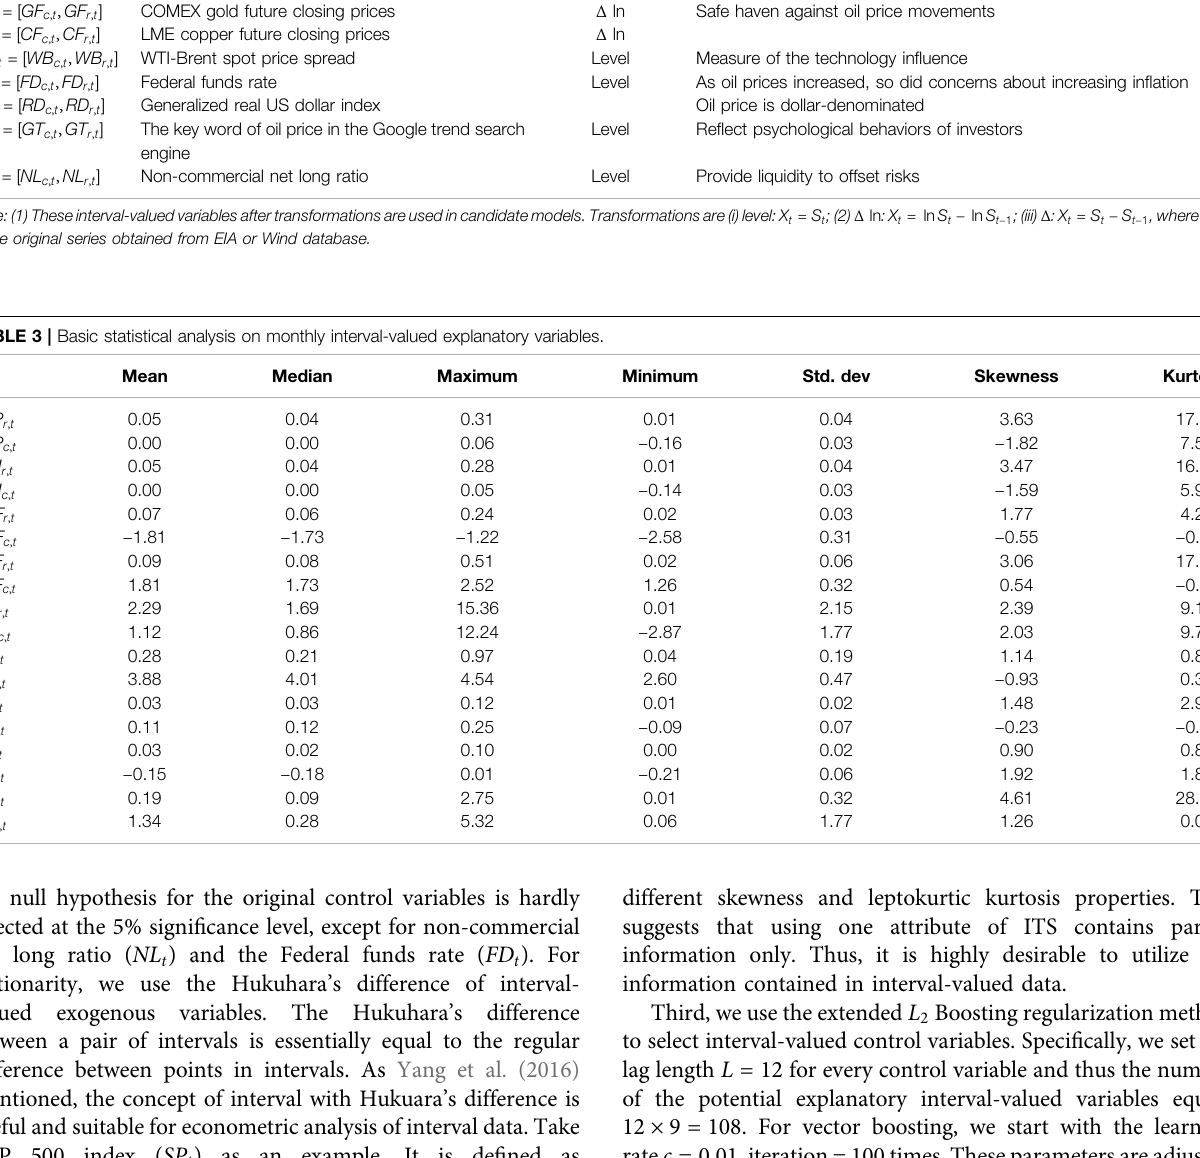
TABLE 2 | Monthly interval-valued exogenous variables. Variables